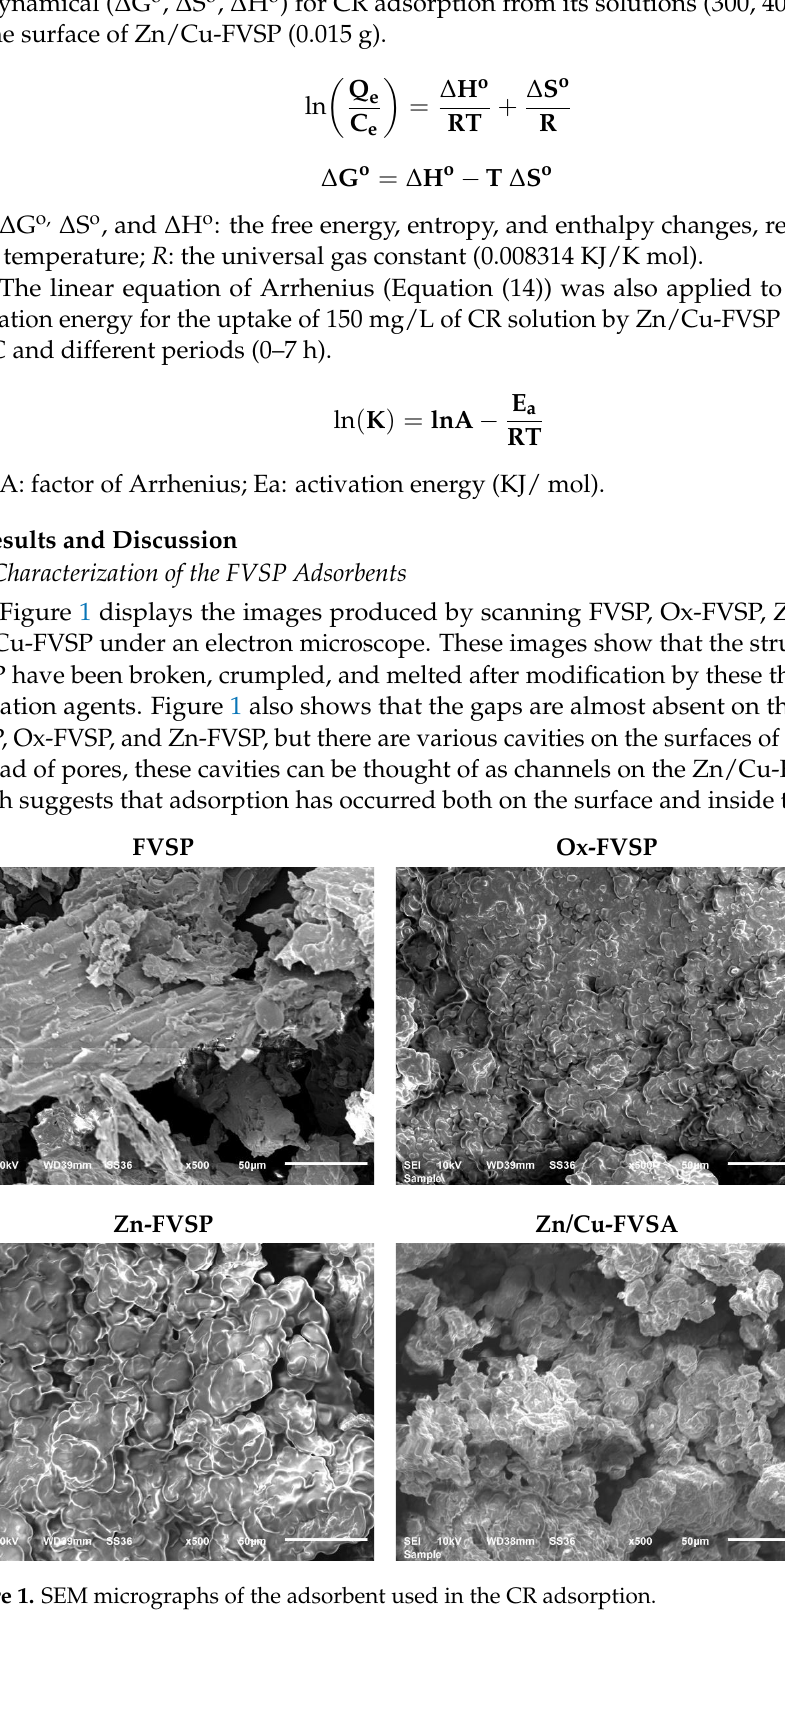
105 Figure 2. FT-IR spectra of the adsorbent used in the Congo red adsorption. 758085 9095 100